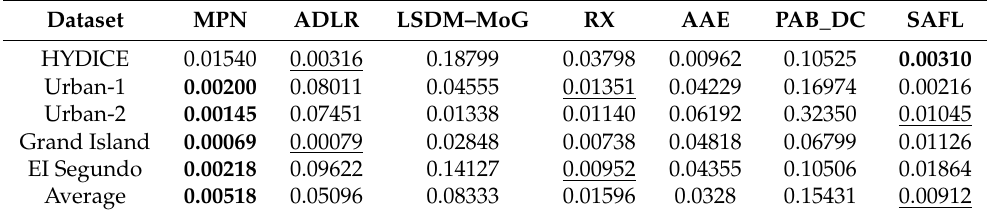
Table 4. Evaluation AUC scores of